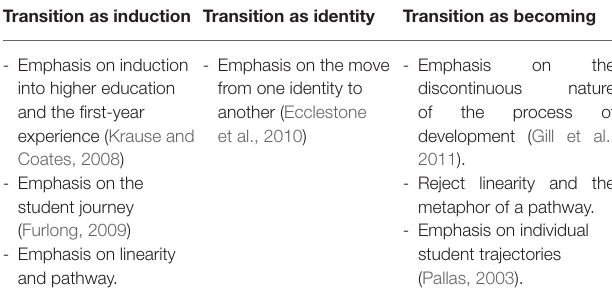
TABLE 1 | Perspectives on university